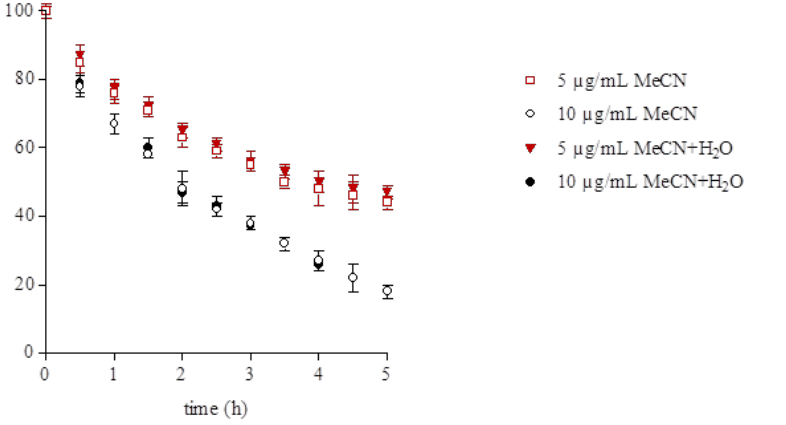
Figure 6. Fucoxanthin content after light exposure expressed as percentage of the initial content in standard solutions (5 and 10 µg/mL) in pure acetonitrile solvent (MeCN) and in